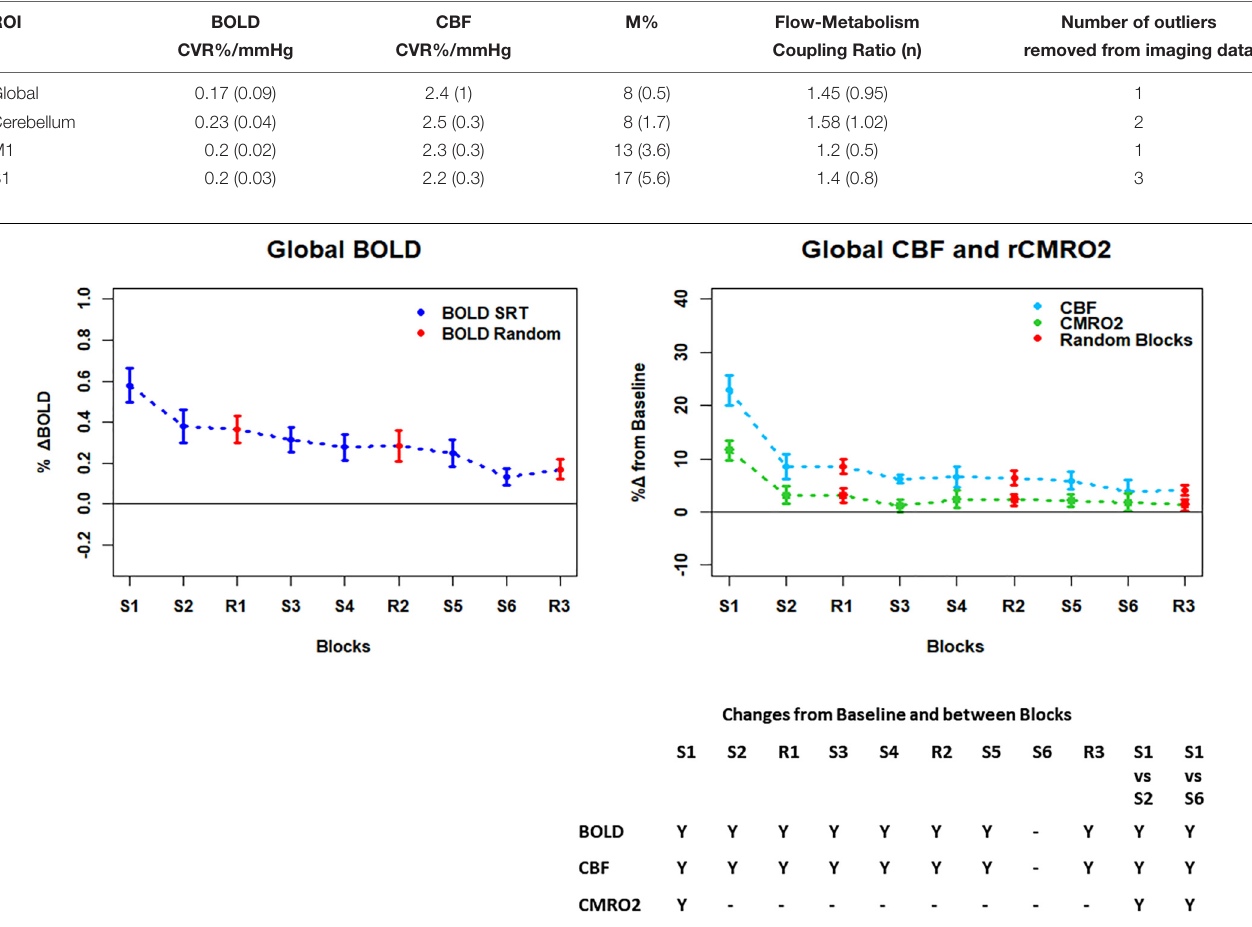
TABLE 1 | Mean (SEM) CVR. M and flow-metabolism coupling ratio ( n ) values for each ROI shown in Figures 4–7 . ROI BOLD CBF M% Flow-Metabolism Number of outliers CVR%/mmHg CVR%/mmHg Coupling Ratio (n) removed from imaging data Global 0.17 (0.09)